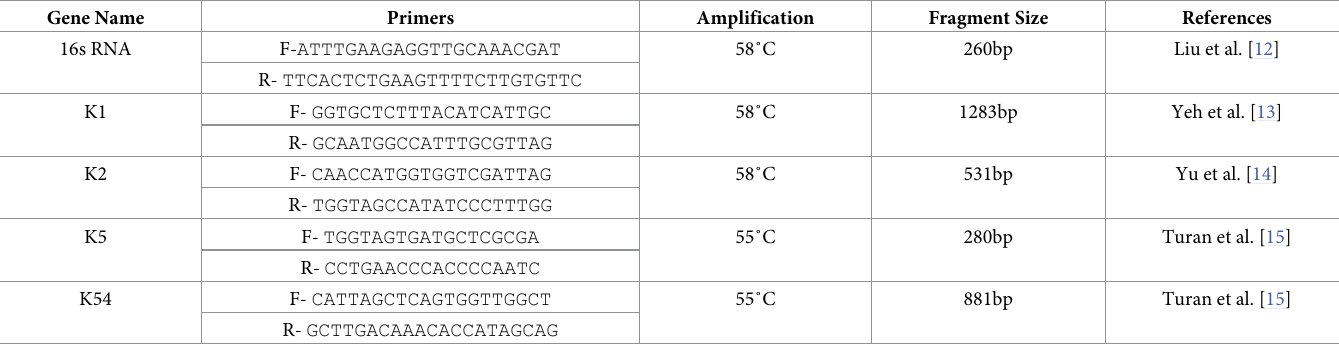
Table 1. Primers used for molecular characterization of MDR K . pneumoniae capsular resistance genes.